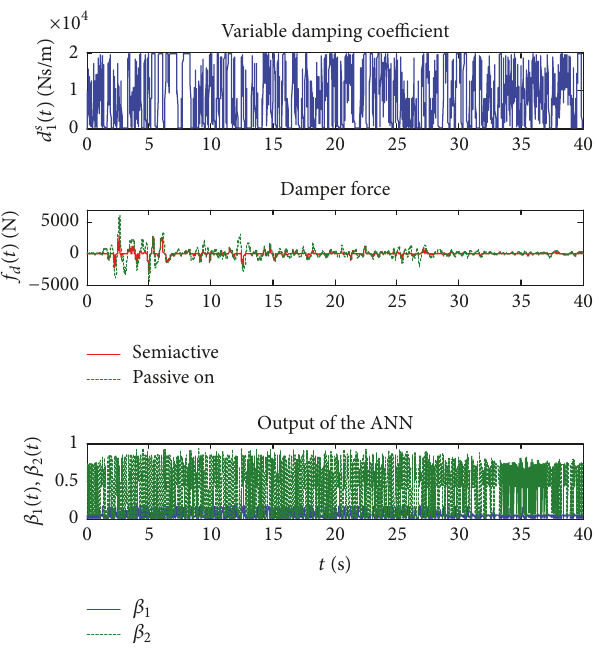
Figure 9: Simulation results for the El Centro NS (1940) earthquake disturbance; variable damping coefficient 𝑑 𝑠 1 (𝑡) , force of damper 𝑓 (𝑡) , and output signals of the ANN 𝛽 𝑑